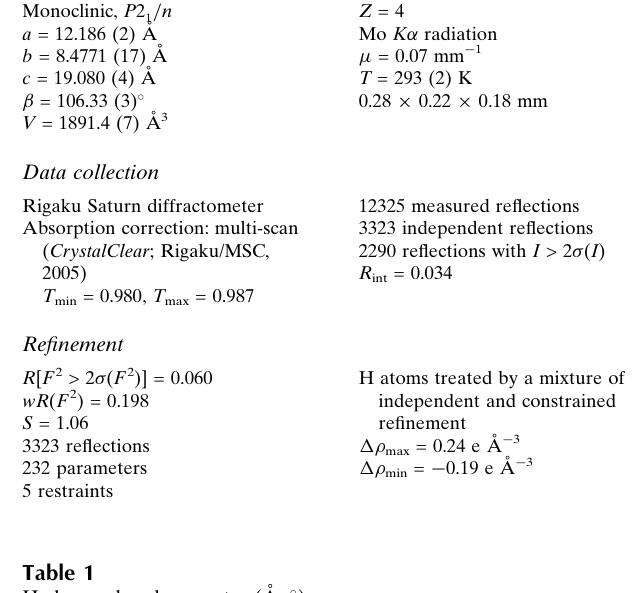
Hydrogen-bond geometry (A˚ , (cid:2)